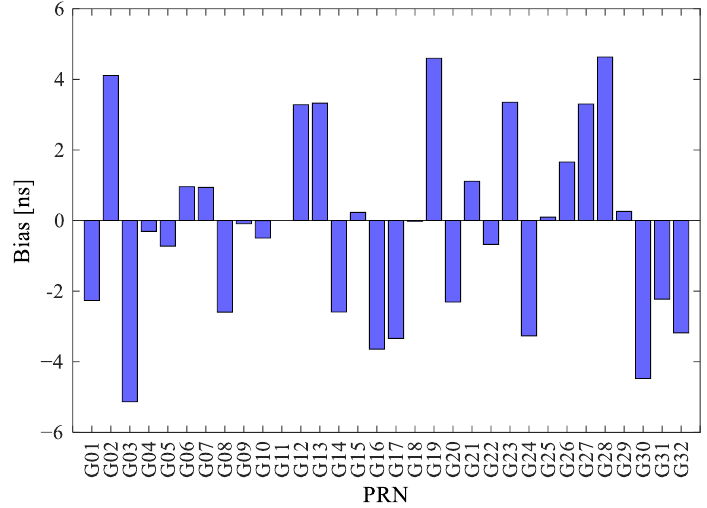
Figure 5. One example of injected bias for each satellite in one day.